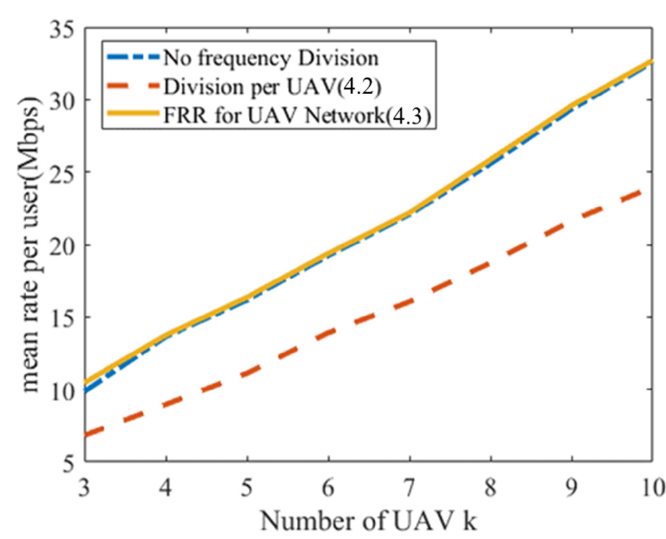
Figure 9. The mean data rate for each number of UAVs.